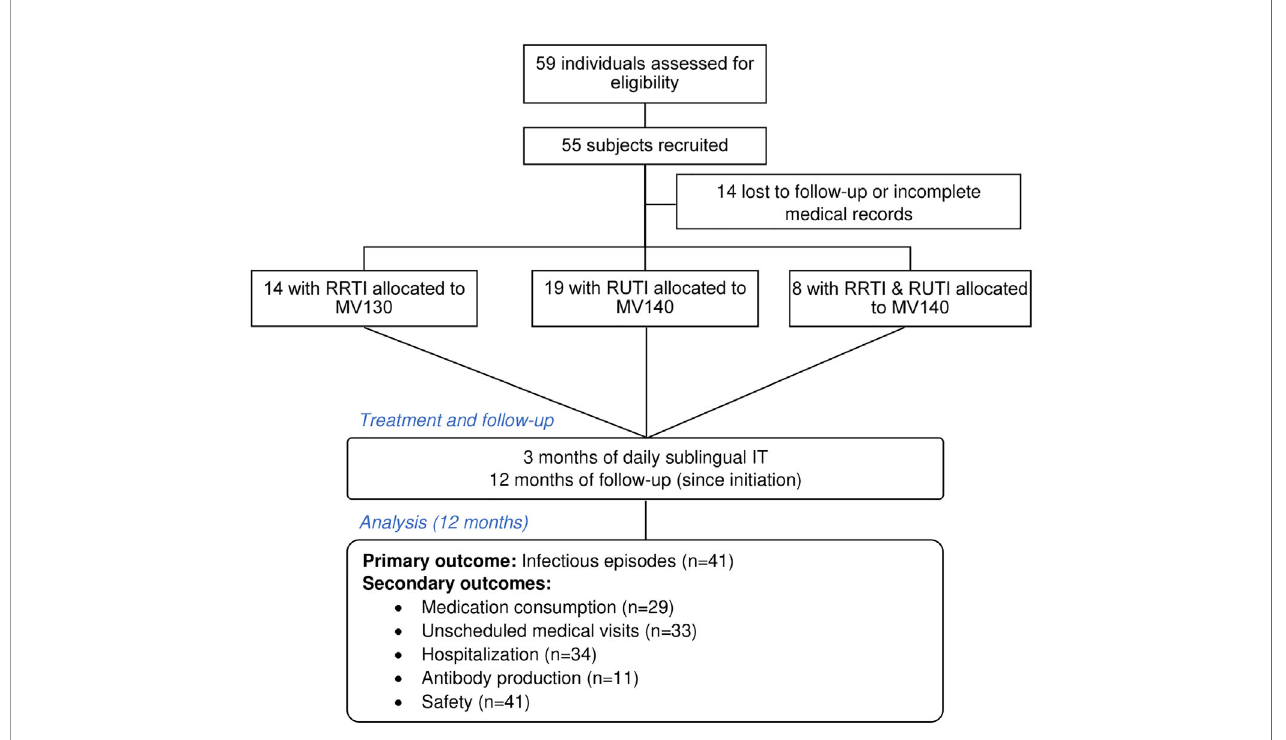
FIGURE 1 | Flow-chart of the study. RRTI, recurrent respiratory tract infections; RUTI, recurrent urinary tract infections; IT,